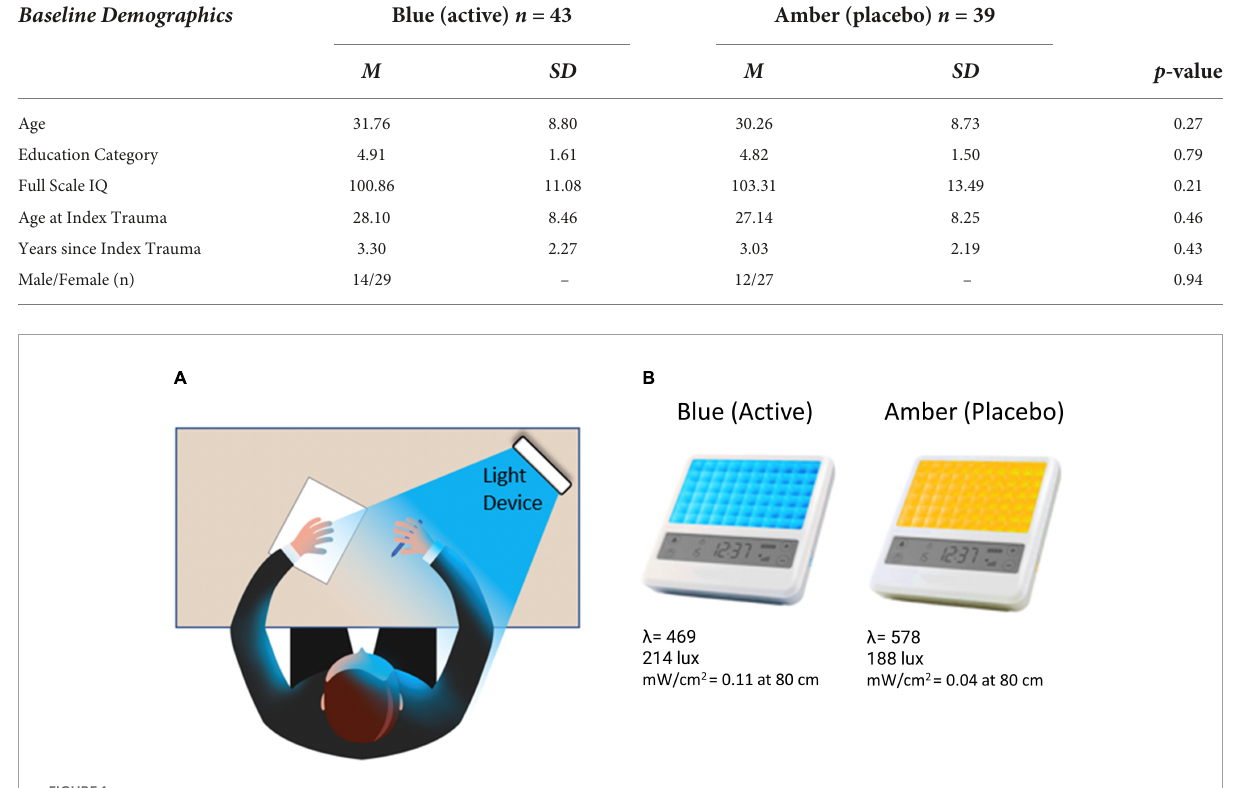
TABLE 1 Baseline demographic characteristics.